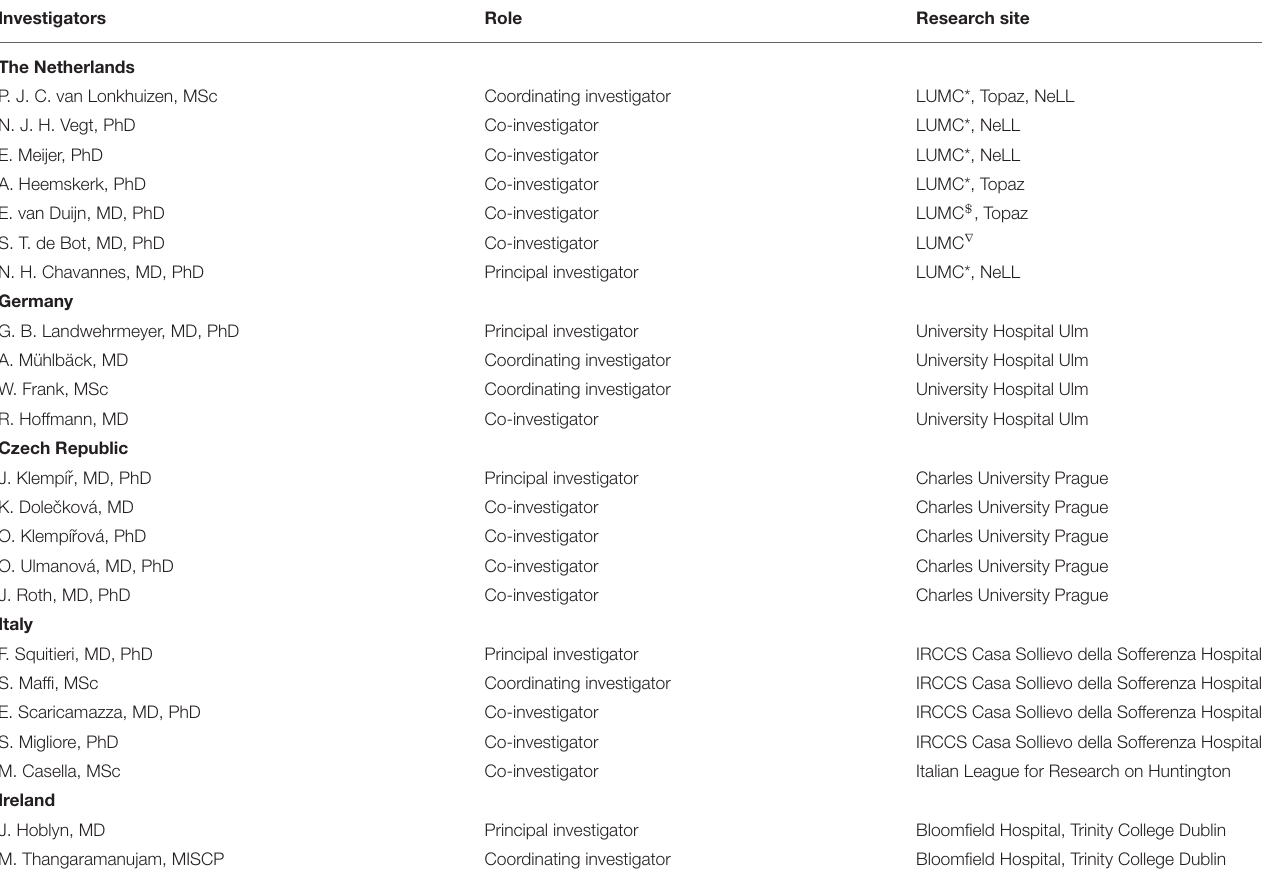
TABLE 1 | Research sites and investigators involved in the